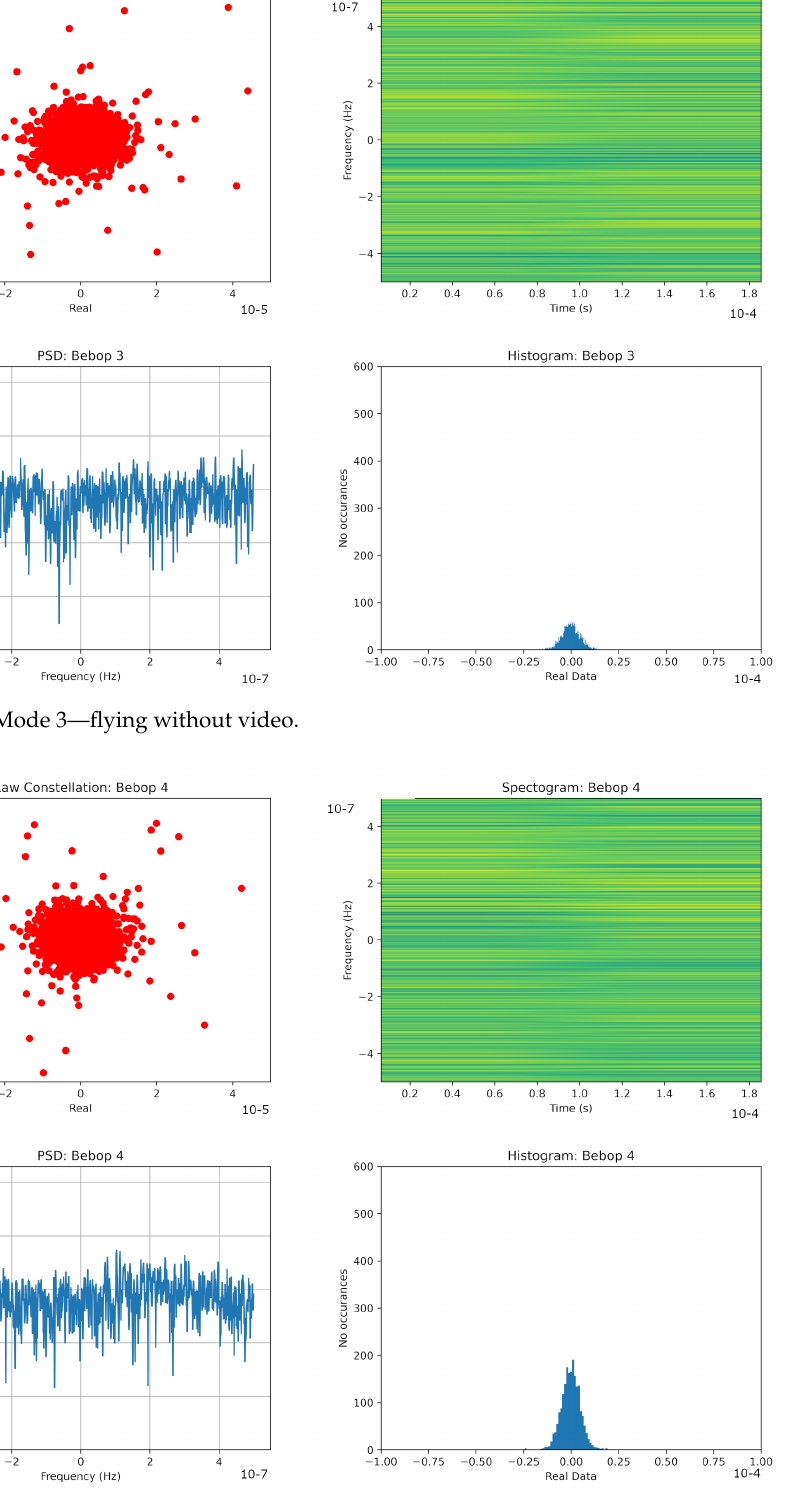
Figure 7. Bebop Mode 4—flying with